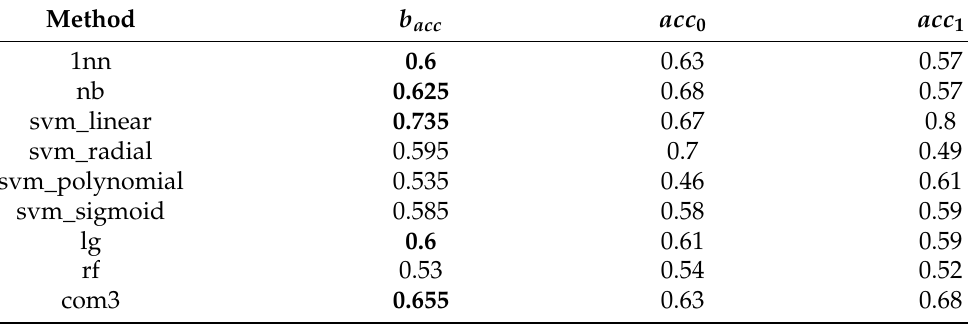
Table 8. Summary of results for data.bee2.2 with baseline